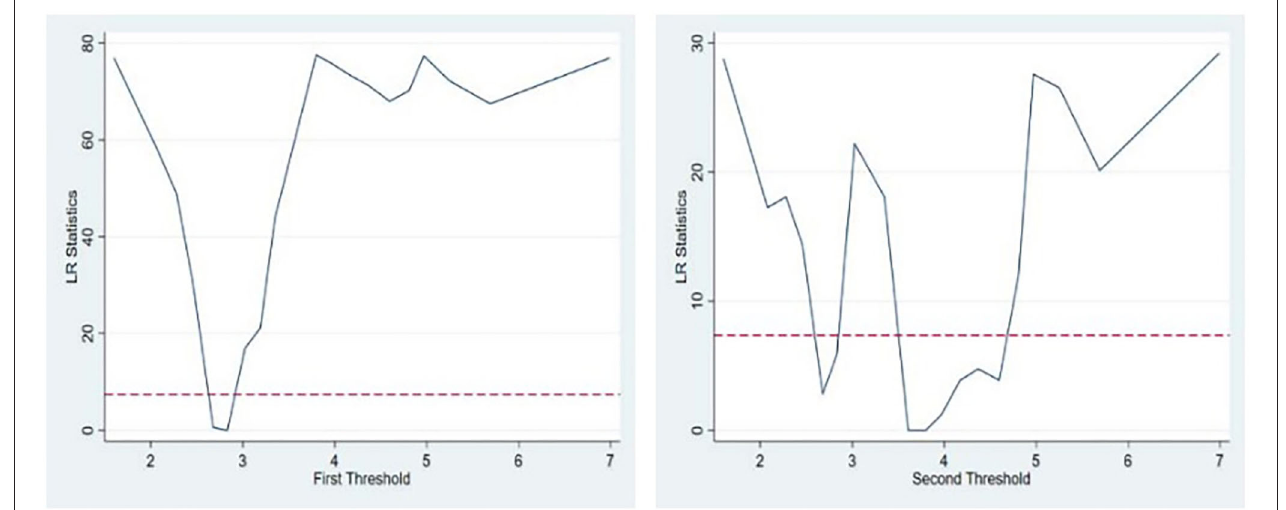
FIGURE 4 | Threshold value diagram.